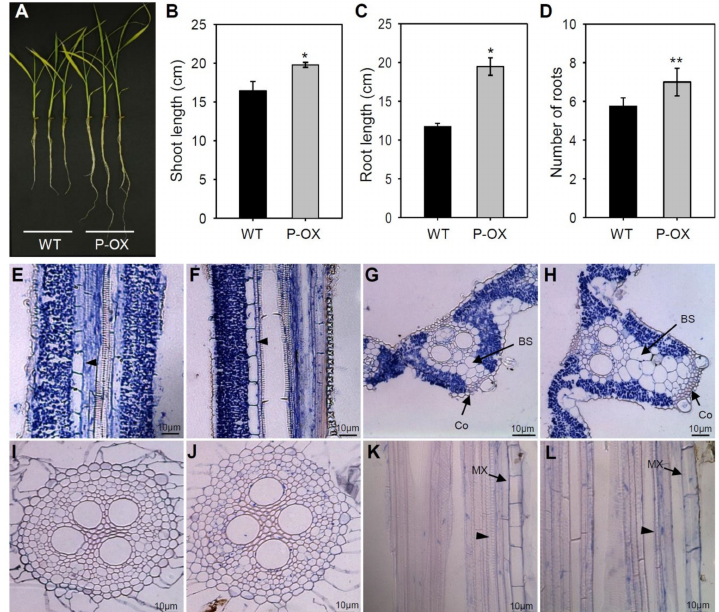
Figure 4. Morphological changes in OsEXPA7 -OX transgenic plants. ( A ) Phenotypic di ff erence in seven-day-old rice seedlings grown hydroponically under normal nutrition conditions. ( B ) Shoot length, ( C ) root length, ( D ) and number of roots in WT and PGD: OsEXPA7 . Longitudinal section of leaf blades in WT ( E ) and PGD: OsEXPA7 plants ( F ) at 40 × . Transverse sections of leaf blade in WT ( G ) and PGD: OsEXPA7 ( H ) at 200 × . Transverse sections of primary roots in WT ( I ) and PGD: OsEXPA7 ( J ). Cell shape and size in WT ( K ) and PGD: OsEXPA7 ( L ) in longitudinal sections. Arrowheads indicate xylems. Statistical significance was determined by a t -test (** p < 0.01, * p < 0.05). LV, large vein. BS, bundle sheath. Co, collenchyma. MX, metaxylem. Photographs shown in (E–L) are representative